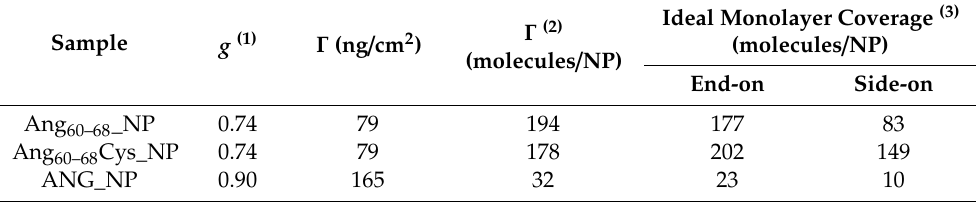
Table 2. Protein fraction shell value ( g ) and peptide / protein coverage ( Γ ) calculated from the changes in the wavelength of maximum absorption ( λ max ) of AuNP plasmon peak for peptide / protein added nanoparticles. The ideal monolayer coverage of the peptide / protein in the end-on and side-on limit configuration are given for